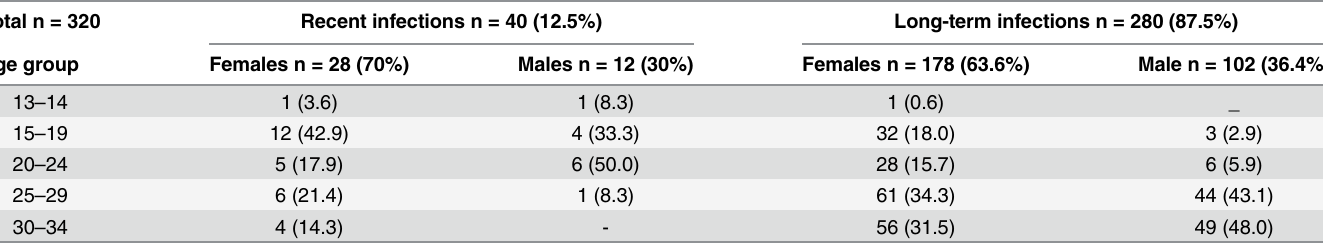
Table 1. Characterization of recent and long-term HIV infections by age and gender, Western Kenya, October 2003 – May 2005. Total n =